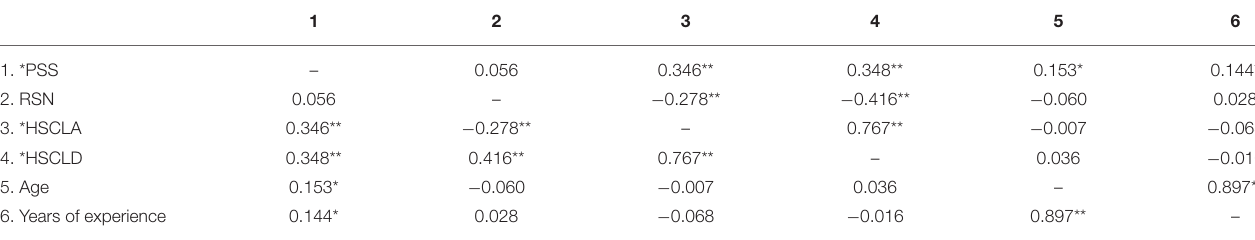
Table 4 | Correlations among the PSS-10, RSN-19, HSCL Anxiety, HSCL Depression, age, and years of